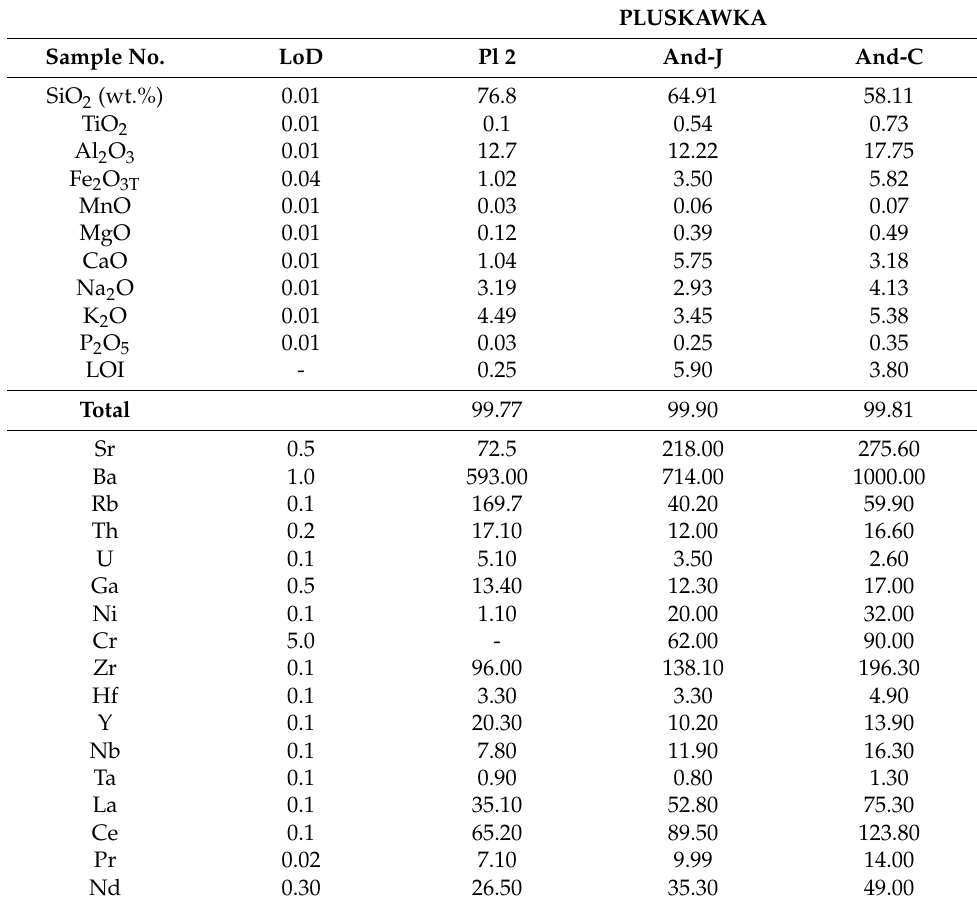
Table 4. Chemical composition and selected petrological indices of the whole-rock samples of crystalline exotic blocks from the Pluskawka